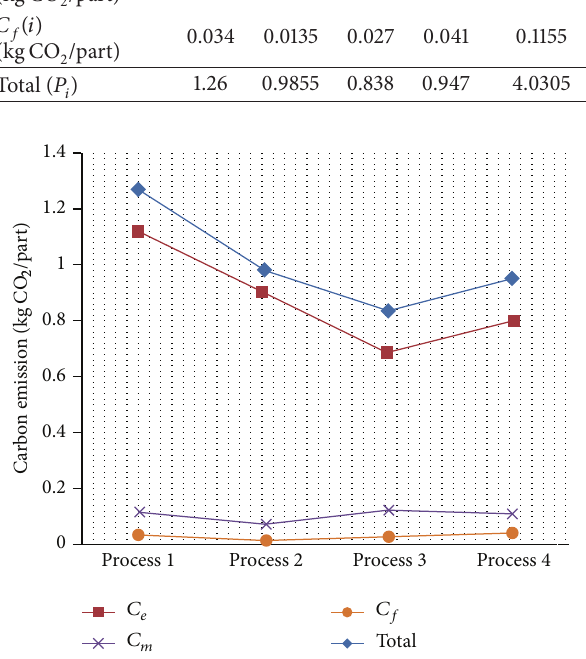
Figure 5: Breakdown of carbon emissions for the manufacture of the